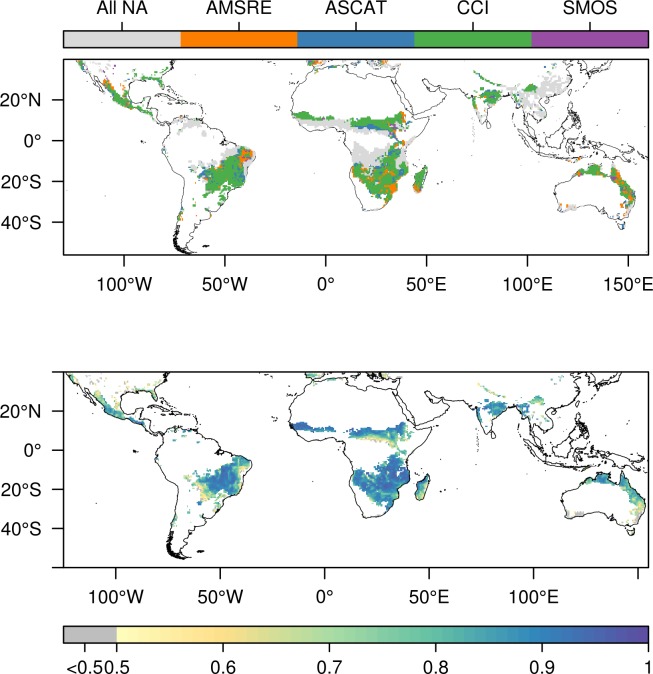
Best dataset analysis.Land borders have been created using data from thematicmapping.org. Top: Per-pixel best dataset identified as the one with the highest correlation between modelled NDVI and MODIS-NDVI using each of the four different soil moisture datasets. All NA indicate missing data in all datasets, no significant correlation to NDVI or correlation below 0.5 in all datasets. Data have for visual purposes been filtered with a 3x3 modal filter. Bottom: Best correlation (r) of modelled NDVI vs observed NDVI per-pixel. For each pixel, the highest correlation value shown as identified in the top panel. Non-significant or missing values are not shown in the plot. The grey color indicates a correlation below 0.5.